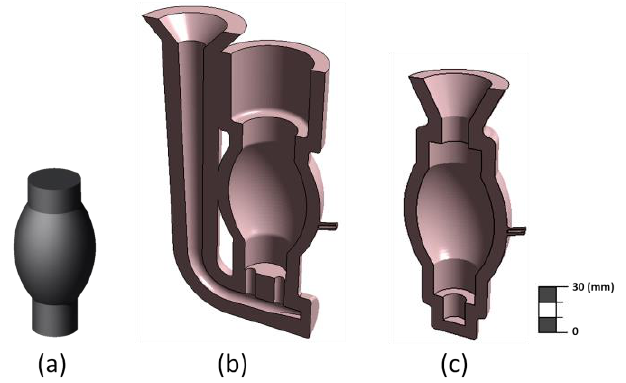
Table 1. Chemical composition of the AlSi alloy (wt.%).